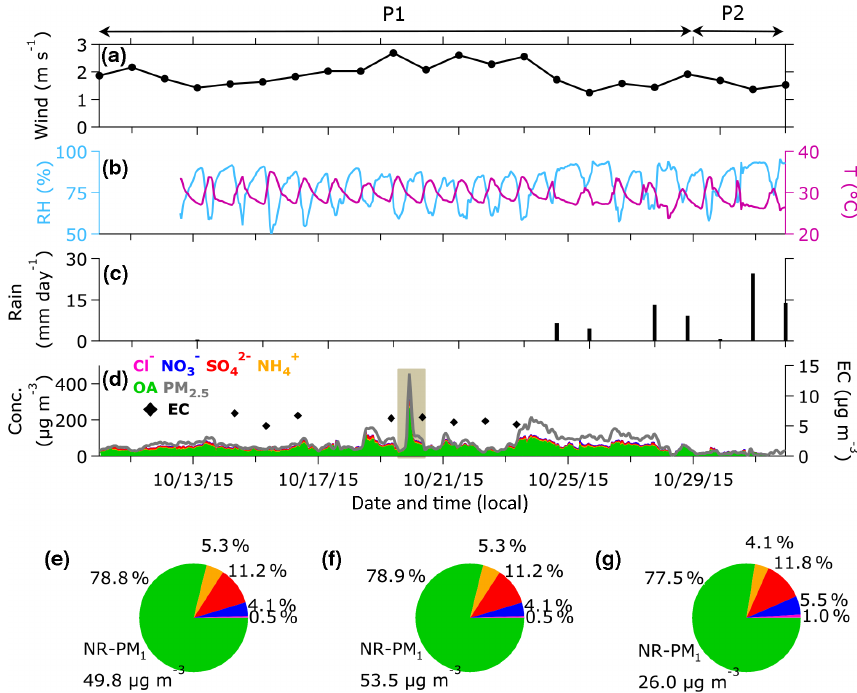
Figure 1. Time profiles of the meteorological parameters and aerosol concentrations. Daily (a) wind speed and (c) precipitation data retrieved from the Meteorological Service Singapore website, hourly (b) relative humidity (RH) and (c) temperature measured at NTU campus from 10 to 31 October 2015. (d) Time profiles of organic aerosol (OA), ammonium (NH + measured by the ToF-ACSM and total PM 2 . 5 mass published on the National Environment Agency website. Pie charts of ToF-ACSM species contribution to the total NR-PM 1 mass for (e) the overall, (f) P1 (10–28 October 2015), and (g) P2 (29–31 October 2015) periods are similarly color coded to the time profiles on plot (d) . The shaded area in plot (d) is referred to as the peak